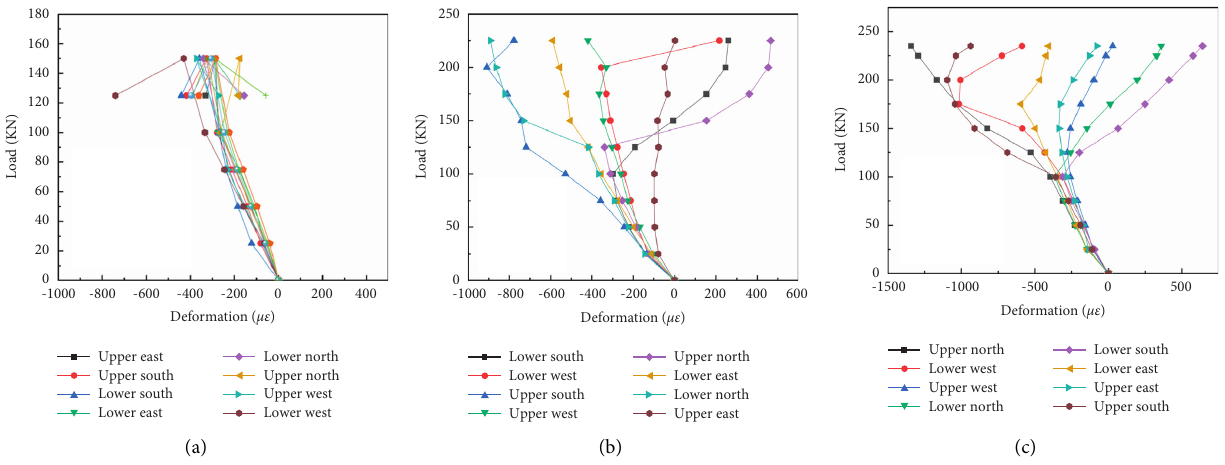
Figure 40: CU series load-strain curves: (a) CU-1, (b) CU-2, and (c)